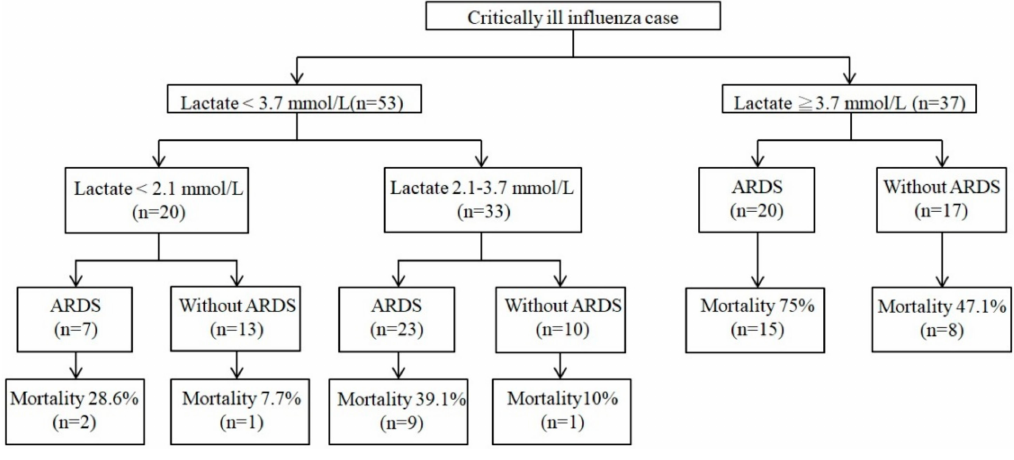
Figure 2. Event-based